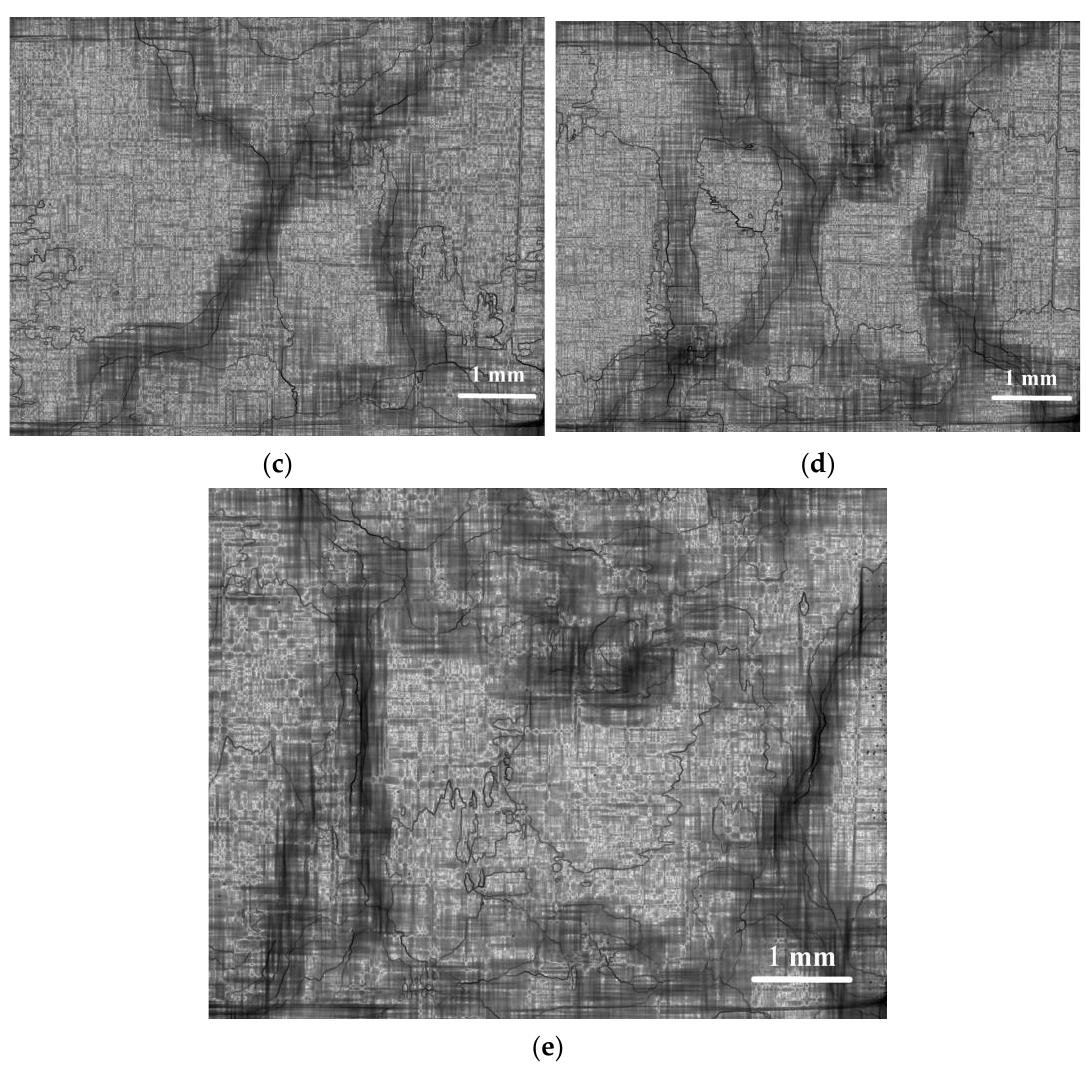
Figure 9. Optical macrograph ( a ) and deformation maps ( b-e ) of Sample #4 at the deformation Stage II at strain are as follows: ε = 0.050 ( a ), ε = 0.034, ∆ ε = 0.0063 ( b ), ε = 0.042, ∆ ε = 0.0063 ( c ) , ε = 0.046, ∆ ε = 0.0063 ( d ), and ε = 0.050, ∆ ε = 0.0063 ( e ).